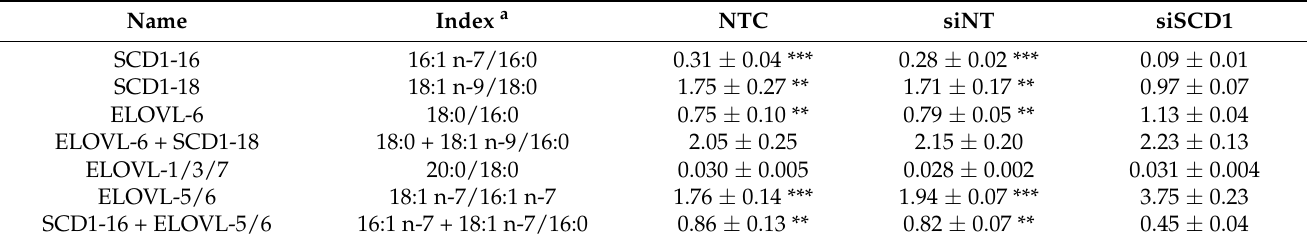
Table 2. Values of indexes for fatty acid desaturation and elongation activities of different